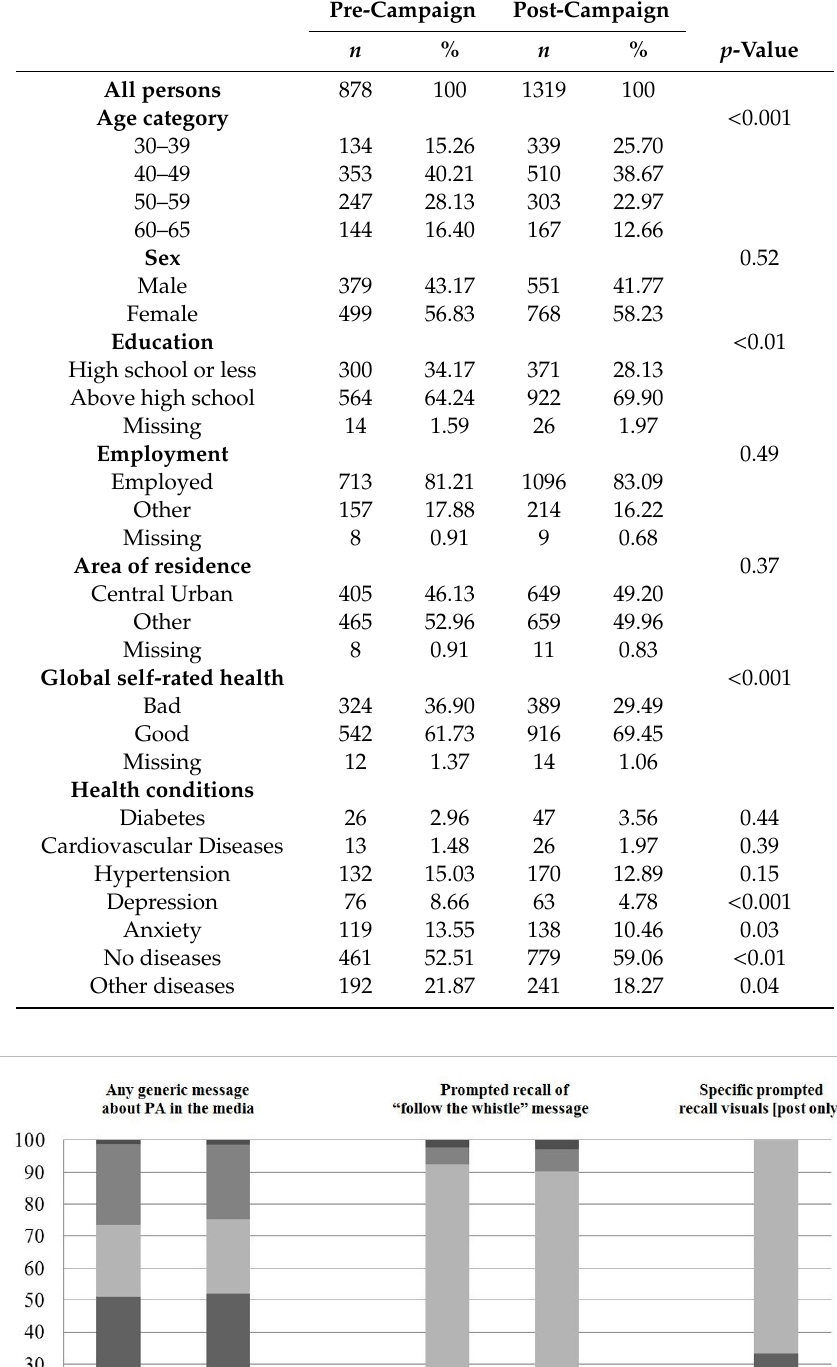
Table 2. Demographic characteristics for all respondents pre- and post-campaign.